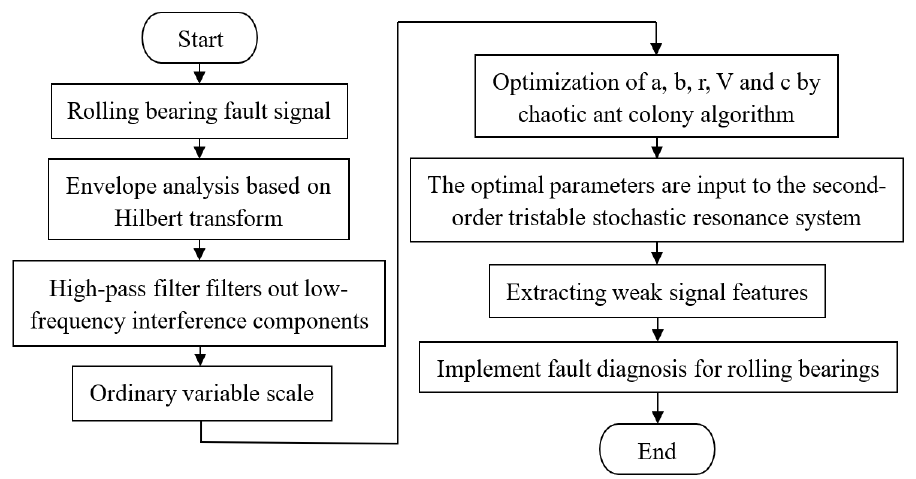
Figure 1. The flow of adaptive STSR method.